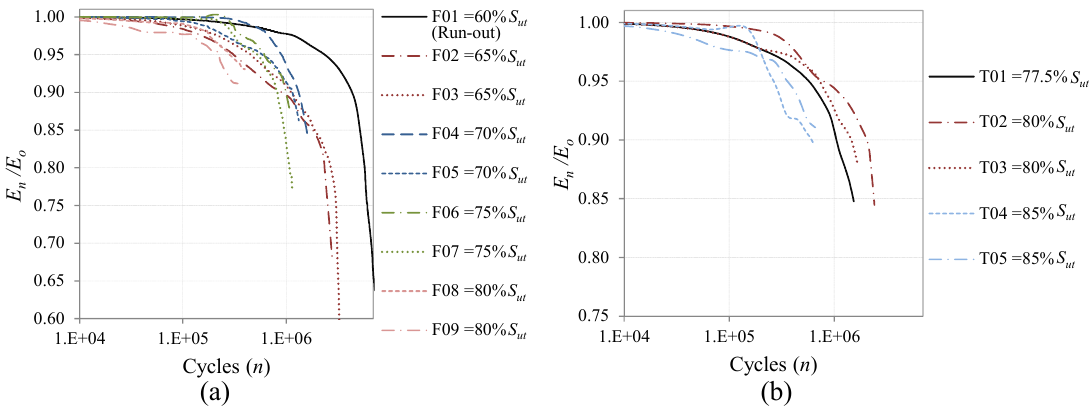
Figure 7. Stiffness degradation of coupons under variable amplitude loads (VAL) with different maximum load; ( a ) Falstaff; ( b ) MiniTwist.